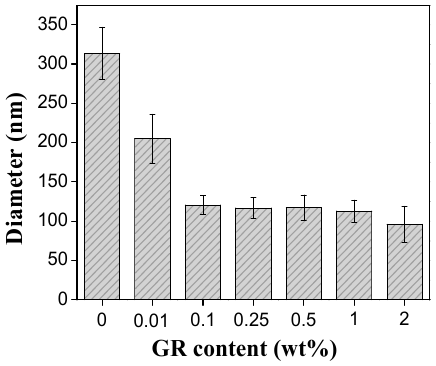
Figure 3. Diameter distribution of PVA/GR nanofiber films as related to the contents of graphene.